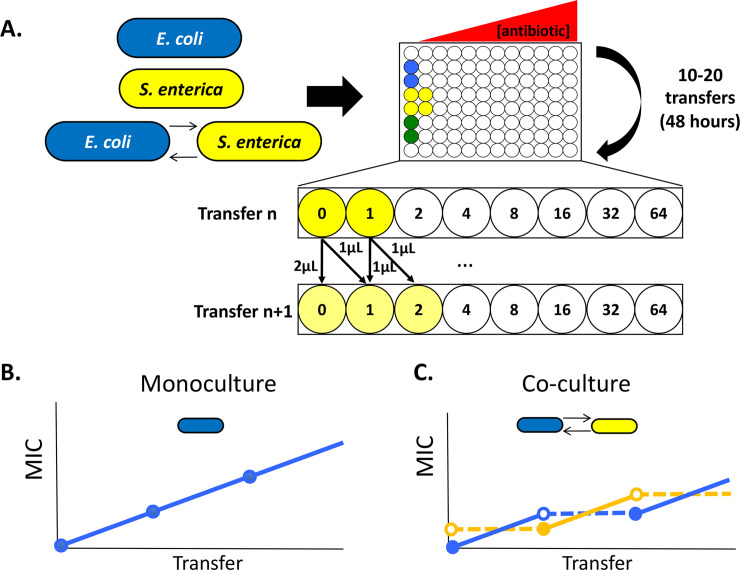
Schematic of experimental setup and expectations.A. Monocultures of E. coli (blue) and S. enterica (yellow), as well as cross-feeding co-cultures (green), were distributed in six replicate populations along an antibiotic gradient in 96-well plates. The antibiotics tested included rifampicin and ampicillin, and the concentration of antibiotic increased twofold at each well. 96-well plates were incubated with shaking at 30°C for 48 hours, then cells were transferred to fresh medium and antibiotic in a new plate. The transfer regime was to transfer 1μL of culture to a fresh well containing the same concentration of antibiotic at which it had previously grown, and 1μL to a fresh well containing one concentration step higher antibiotic. At each passage, the OD600 of the plate was measured, as well as species-specific fluorescence (CFP for E. coli, YFP for S. enterica). B-C. Hypothesis on why time under selection may be sufficient to explain MIC differences between monocultures and co-cultures. B. In monoculture, each species is under selection at every time step, thus selecting for increasing resistance with each passage. C. In obligate co-culture, only the more antibiotic-sensitive species is under selection at a given time, and effective co-culture resistance requires an increase in MIC in both species. This leads to the slower rise in resistance in the co-culture.